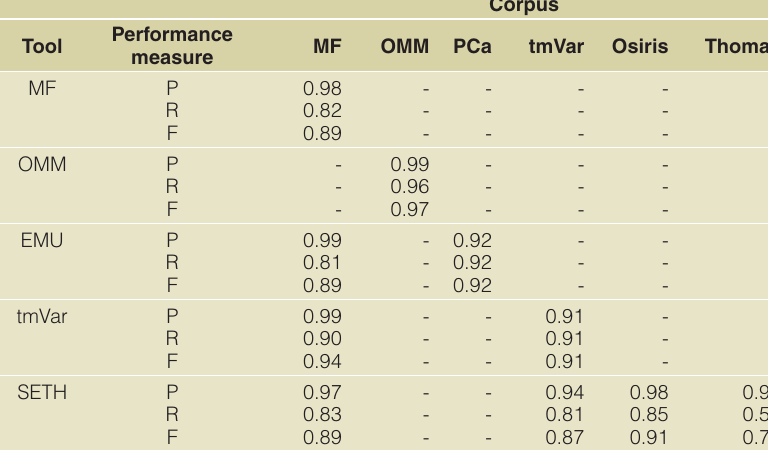
Table 1. Mutation extraction systems evaluation on existing corpora. The results in precision, recall and F1 measure are obtained from already published studies or the tool website like SETH. A dash(-) is used to indicate that no results are available. The tools are MutationFinder (MF), OpenMutationMiner (OMM), Extractor of Mutations (EMU), tmVar and SNP Extraction Tool for Human Variations (SETH). The corpora used for evaluation are MutationFinder corpora (MF), OpenMutationMiner corpora (OMM), EMU Prostate Cancer set (PCa), the tmVar corpora, the OSIRIS corpora and the corpora made available by Thomas et al. 24